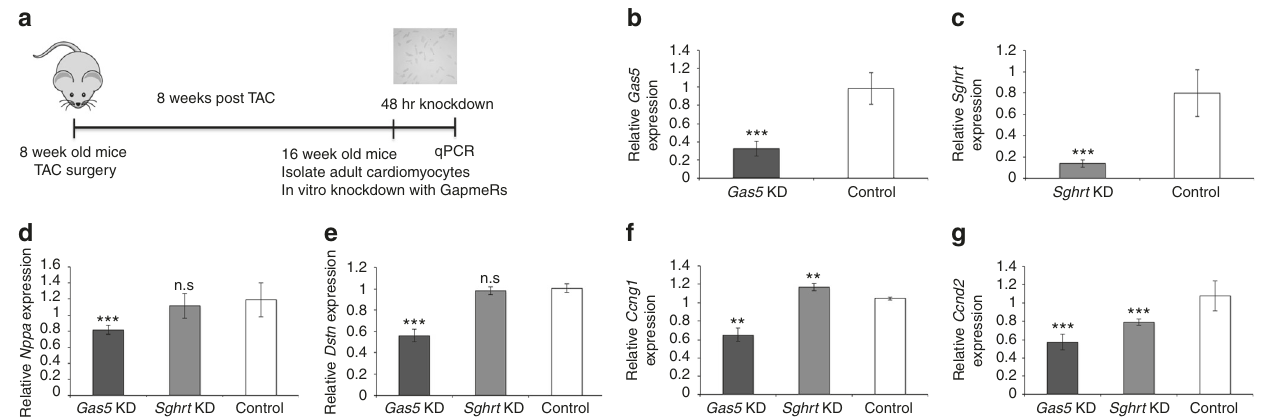
Fig. 6 Gas5 and Sghrt regulate co-regulated network gene expression. a Strategy to KD Gas5 or Sghrt independently in isolated adult TAC CMs in vitro. Cartoon from openclipart.org, under a CC0 1.0 Universal license. b , c In vitro KD of Gas5 or Sghrt in adult mouse CMs using GapmeRs is ef fi cient and reproducible across biological replicates. N = 5 biological replicates. d – g Gas5 KD in TAC CMs results in signi fi cant reduction of Nppa , Dstn , Ccng1 , and Ccnd2 expression. Sghrt KD in TAC CMs results in signi fi cant increase in Ccng1 and reduction in Ccnd2 expression. N = 5 biological replicates.